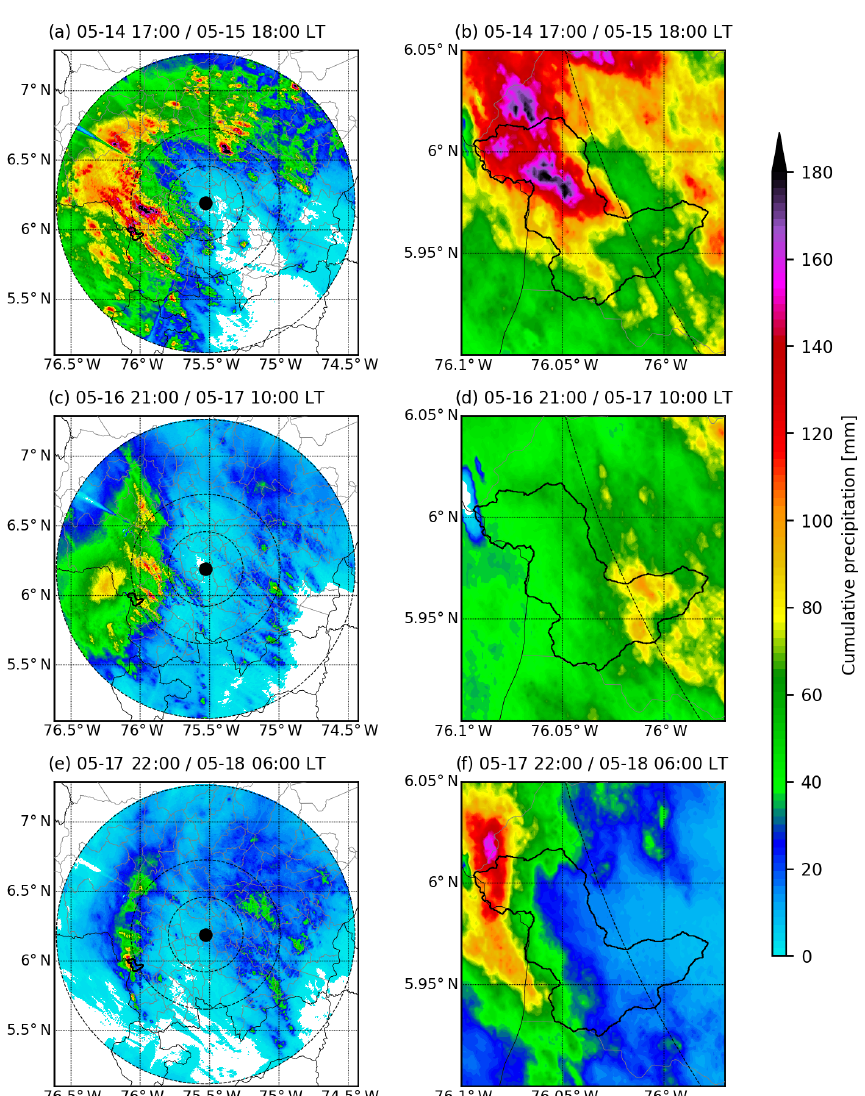
Figure 10. Cumulative precipitation for the three events prior to the La Liboriana flash flood obtained using the radar QPE technique. The panels show the spatial distribution of precipitation for a 120km radius area centered at the radar site and for the La Liboriana basin. (a, b) Cumulative precipitation during the 25h between 14 May, 17:00LT, and 15 May, 18:00LT; (c, d) cumulative precipitation during the 13h between 16 May, 21:00LT, and 17 May, 10:00LT; and (e, f) precipitation between 17 May, 22:00LT, and 18 May,